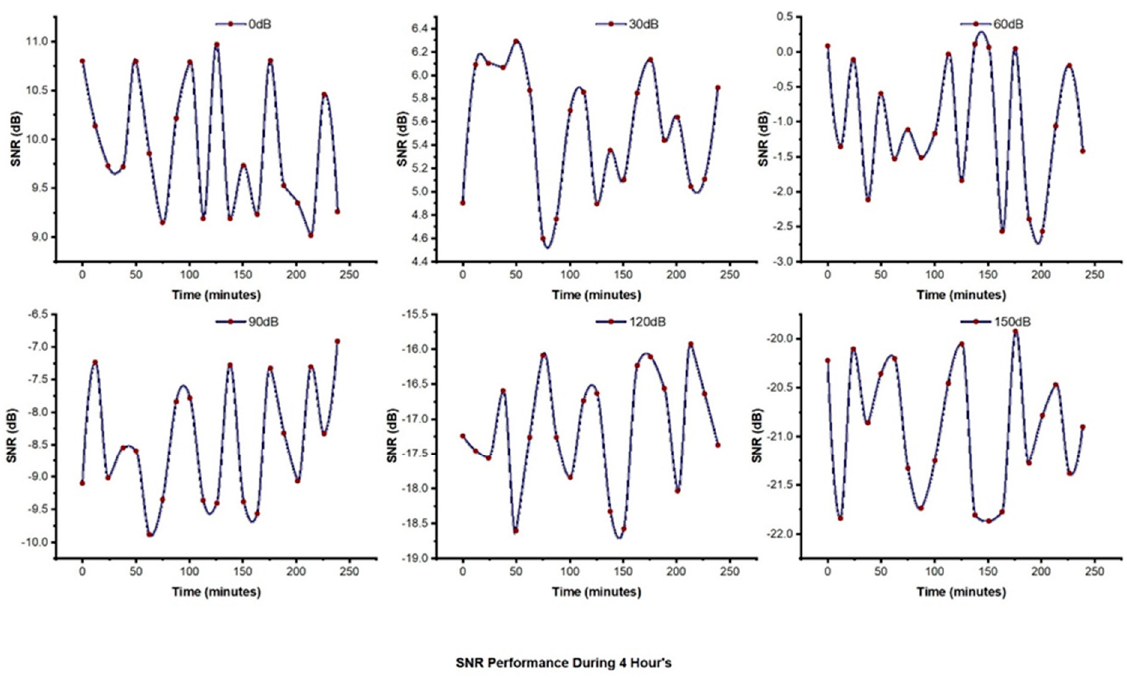
Figure 11. Results of Signal − to − Noise Ratio (SNR) during the four-hour window.